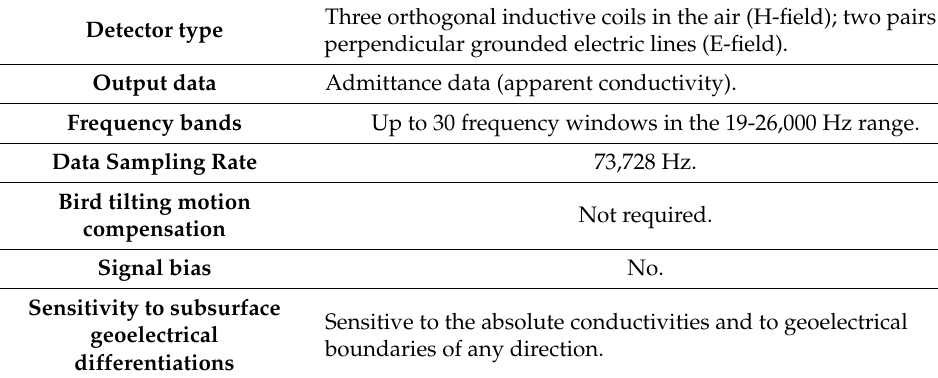
Table 3. Technical specifications of the MobileMT